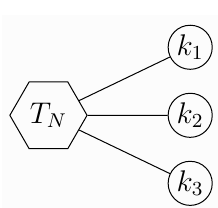
× SU( N ) k 1 + 1 /k + 1 /k = 0 1 2 3